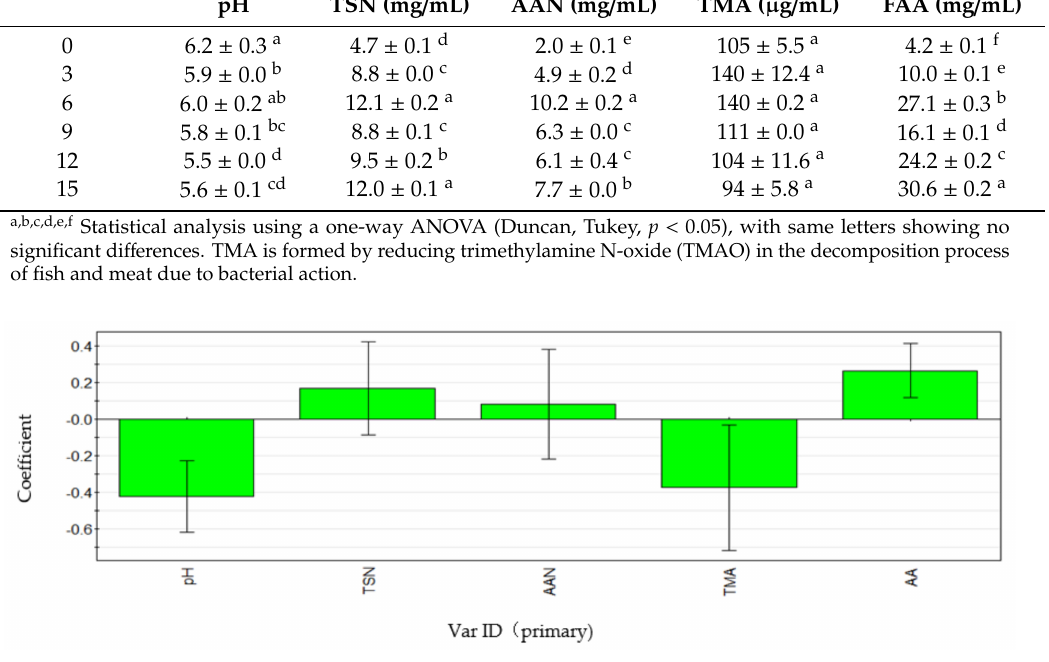
Table 1. Analysis of the physical and chemical indicators in fish sauce at di ff erent fermentation stages. Time (months)